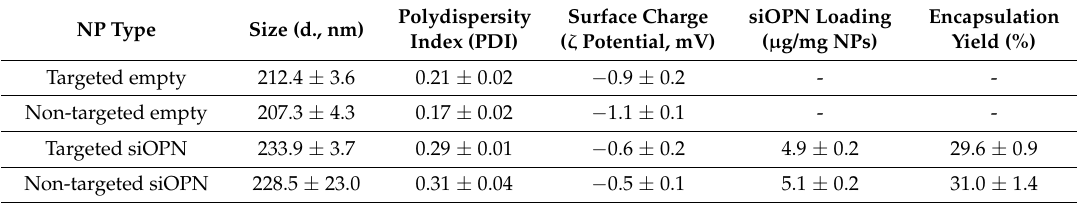
Table 1. Physicochemical properties of targeted and non-targeted NPs (mean ± SD).